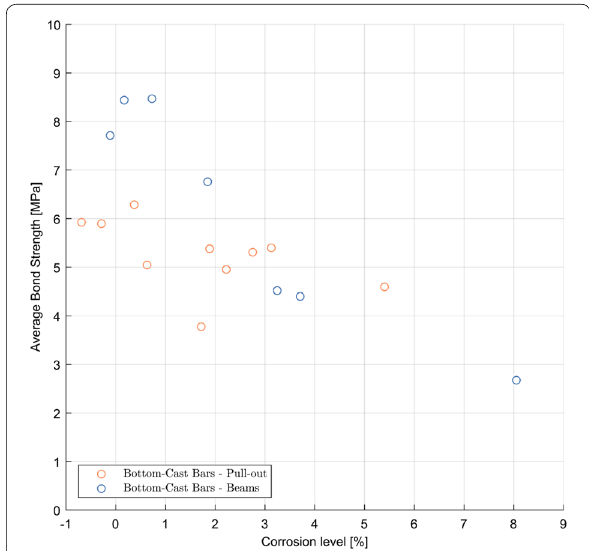
Fig. 12 Average bond strength and corresponding average corrosion level of bottom cast bars. Each point in the graph represents the bond strength of the tested bars averaged over an interval of 0.5% of